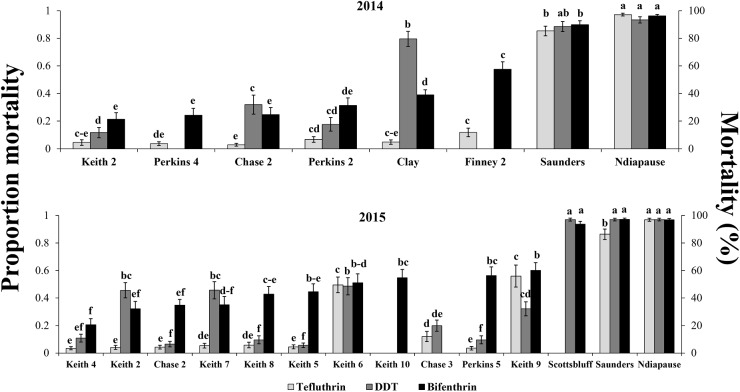
Mean proportion western corn rootworm adult mortality (± SE) at diagnostic concentration (LC99) of field populations and a susceptible non-diapause population in 2014 and 2015 bioassays for the insecticides bifenthrin, tefluthrin, and DDT.N = at least 10 reps of 10 beetles per bioassay; LC99: Bifenthrin = 0.77 μg/vial; Tefluthrin = 0.60 μg/vial; DDT = 6.02 μg/vial. Within insecticides, means with the same letter above bars are not significantly different (LSmeans test, p>0.05). Bifenthrin data for 2014 taken from Pereira et al. (2015).